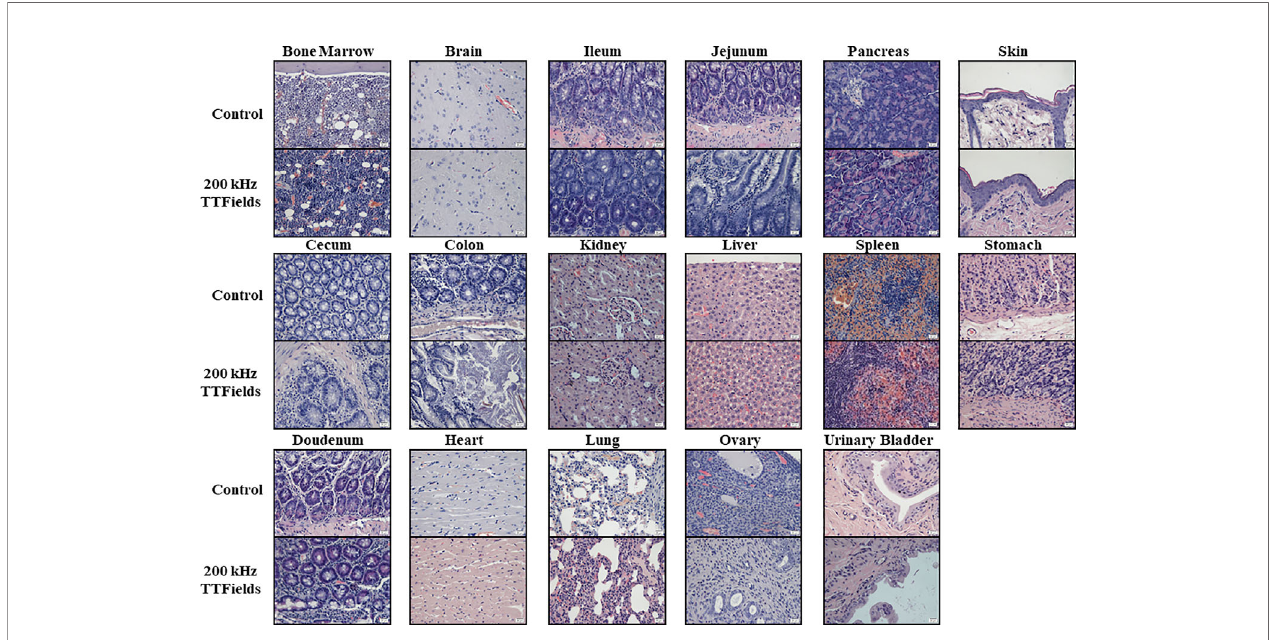
FIGURE 5 | Histopathology analysis of internal organs from animals at the end of 2 weeks of sham or 200 kHz TTFields treatment. Images from one representative animal from each group are shown (H&E staining, ×20 magni fi cation). TABLE 2 | Average EF intensities (V/cm RMS) at 1, 2, and 3 cm depth into the abdomen of healthy rats treated to the torso with 150 kHz (250 mA) or 200 kHz (280 mA) TTFields, based on direct measurements or computer simulations. Depth [cm] 150 kHz TTFields 200 kHz TTFields Measured (± SD) EF intensity [V/cm RMS]